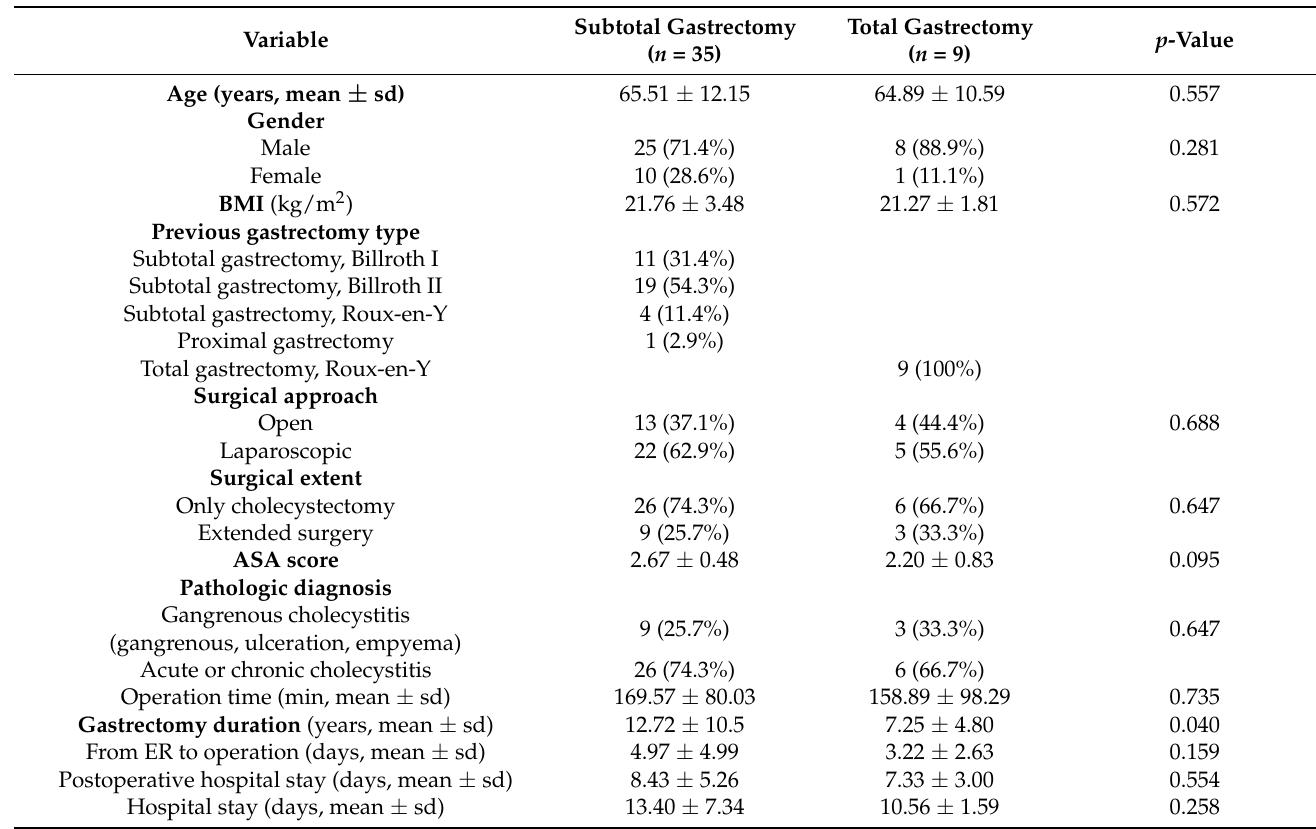
Table 5. Clinical characteristics according to subtotal gastrectomy and total